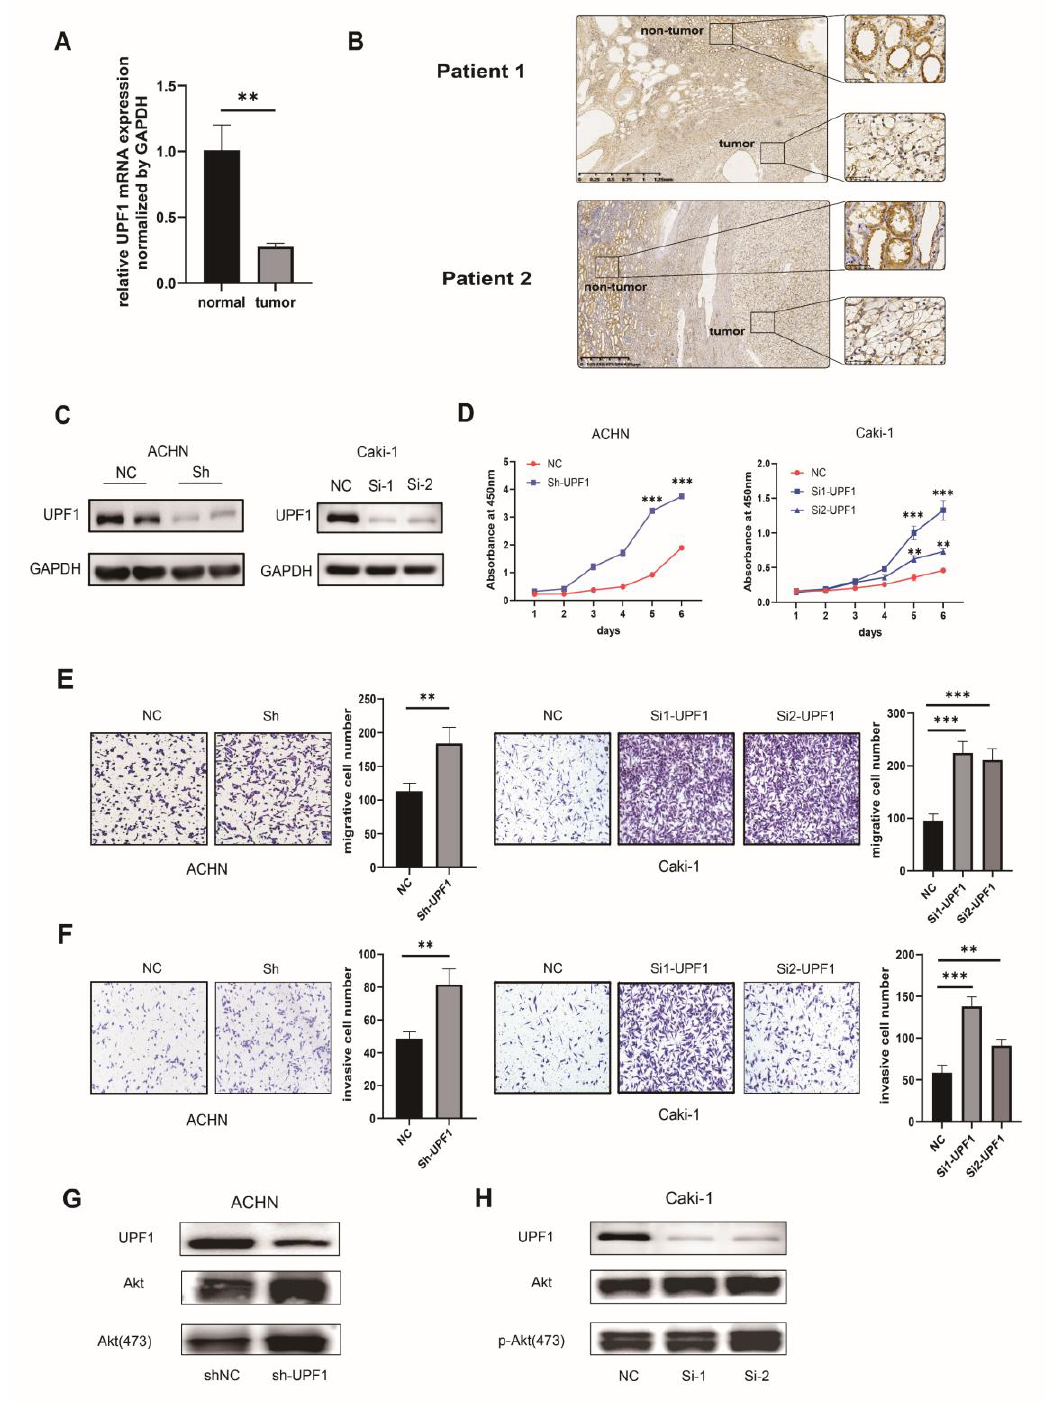
Figure 7. Experimental validation of the role of UPF1 in ccRCC cells. ( A ) qRT-PCR results of UPF1 expression in normal kidney and ccRCC tissues. ( B ) UPF1 protein was strong positive in adjacent nontumor tissues and weak in ccRCC tissues. ( C ) Western blots confirmed the changes in UPF1 expression. ( D ) The proliferation ability of ACHN and Caki-1 cells was measured by the CCK8 assay after transfecting UPF1 shRNA. The migration ( E ) and invasion ( F ) of ACHN and Caki-1 cells were performed in the control group and the si-UPF1 group. ( G , H ) Knockdown of UPF1 active the AKT signal pathway in ACHN and Caki-1 cell lines. ns, p ≥ 0.05; ** p < 0.01; *** p < 0.001.